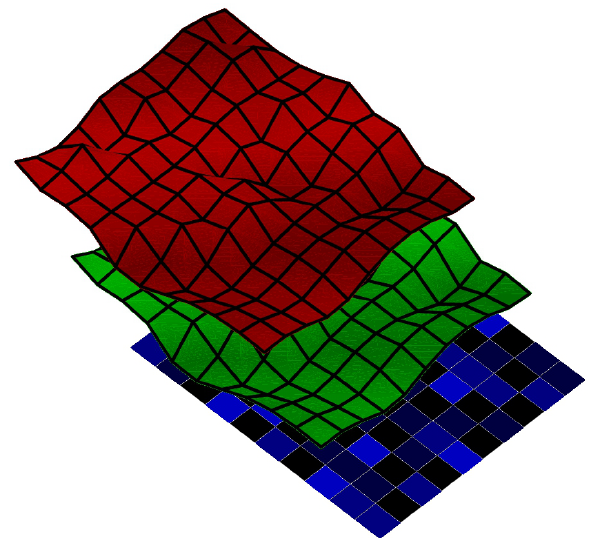
Figure 1: This distance texture is used in a displacement shader to create an output mesh which ideally matches a target mesh. Three color channels are used to encode distance values. The red and green channels are used to store distance values, whereas the blue channel is used to store additional information.